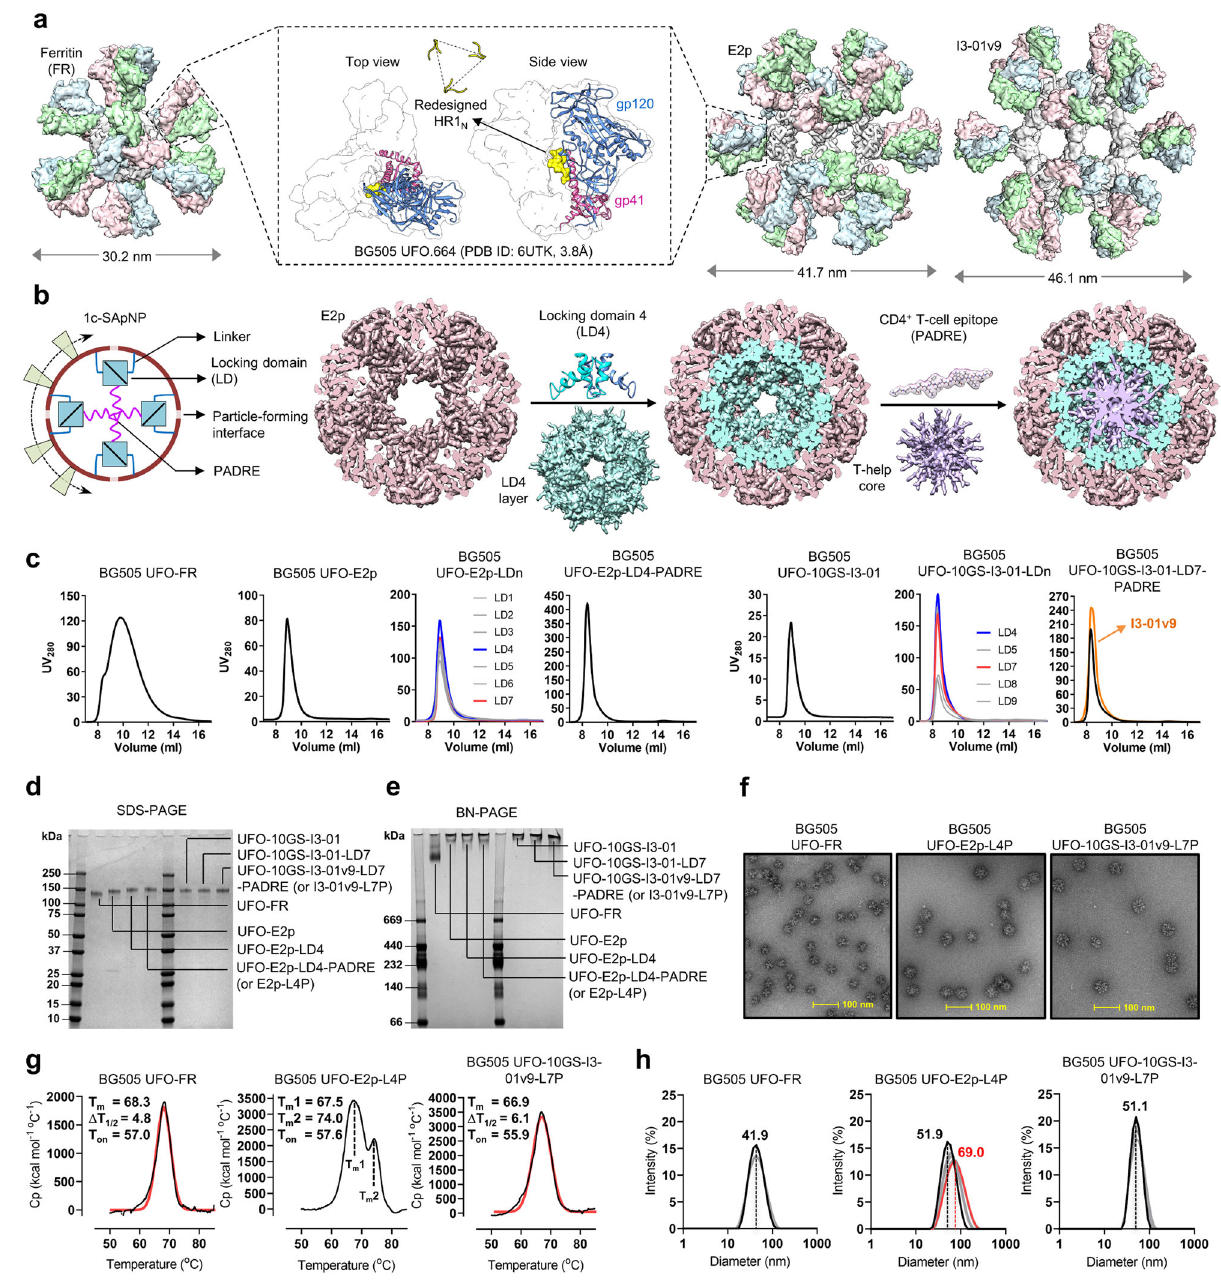
Fig. 1 | Rational design and characterization of BG505 UFO trimer-presenting nanoparticles. a BG505 UFO Env (middle) and three UFO trimer-presenting SApNPs (FR:left;E2p and I3-01:right).In the inset, ribbonrepresentation of BG505 UFO gp140 protomer (PDB ID: 6UTK) is shown in transparent molecular surface with gp120 in corn fl ower blue, gp41 in magenta, and the redesigned HR1 N loop in yellow(asbothribbonand molecularsurface models).Surfacerepresentations are shown for FR 24-mer and E2p/I3-01 60-mers presenting 8 and 20 BG505 UFO tri- mers, respectively. The NP carrier is colored in gray and the three protomers